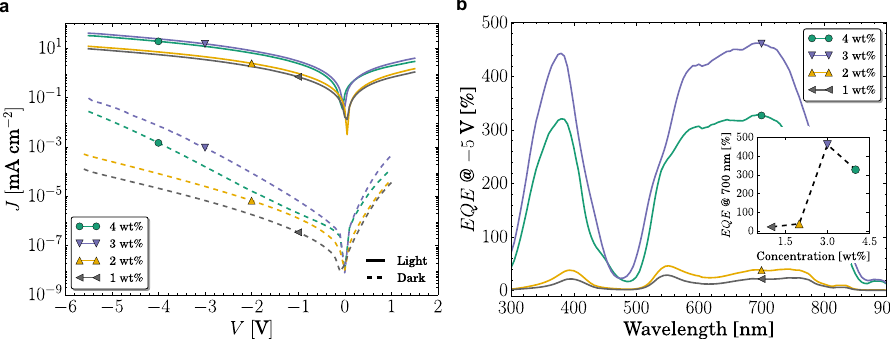
Fig. 2 Electrical characteristics of PM-OPD. a JV curves in dark (dashed lines) and under 100 mW cm − 2 illumination (solid lines) of devices based on ZnPc:C 60 at different concentrations. A clear increase of the light and dark current is observed for devices with concentration higher than 3 wt%. b EQE of the same devices showed in a , measured at − 5 V. The observed increase in current under illumination results in an increased EQE over 100%, achieving maximum of